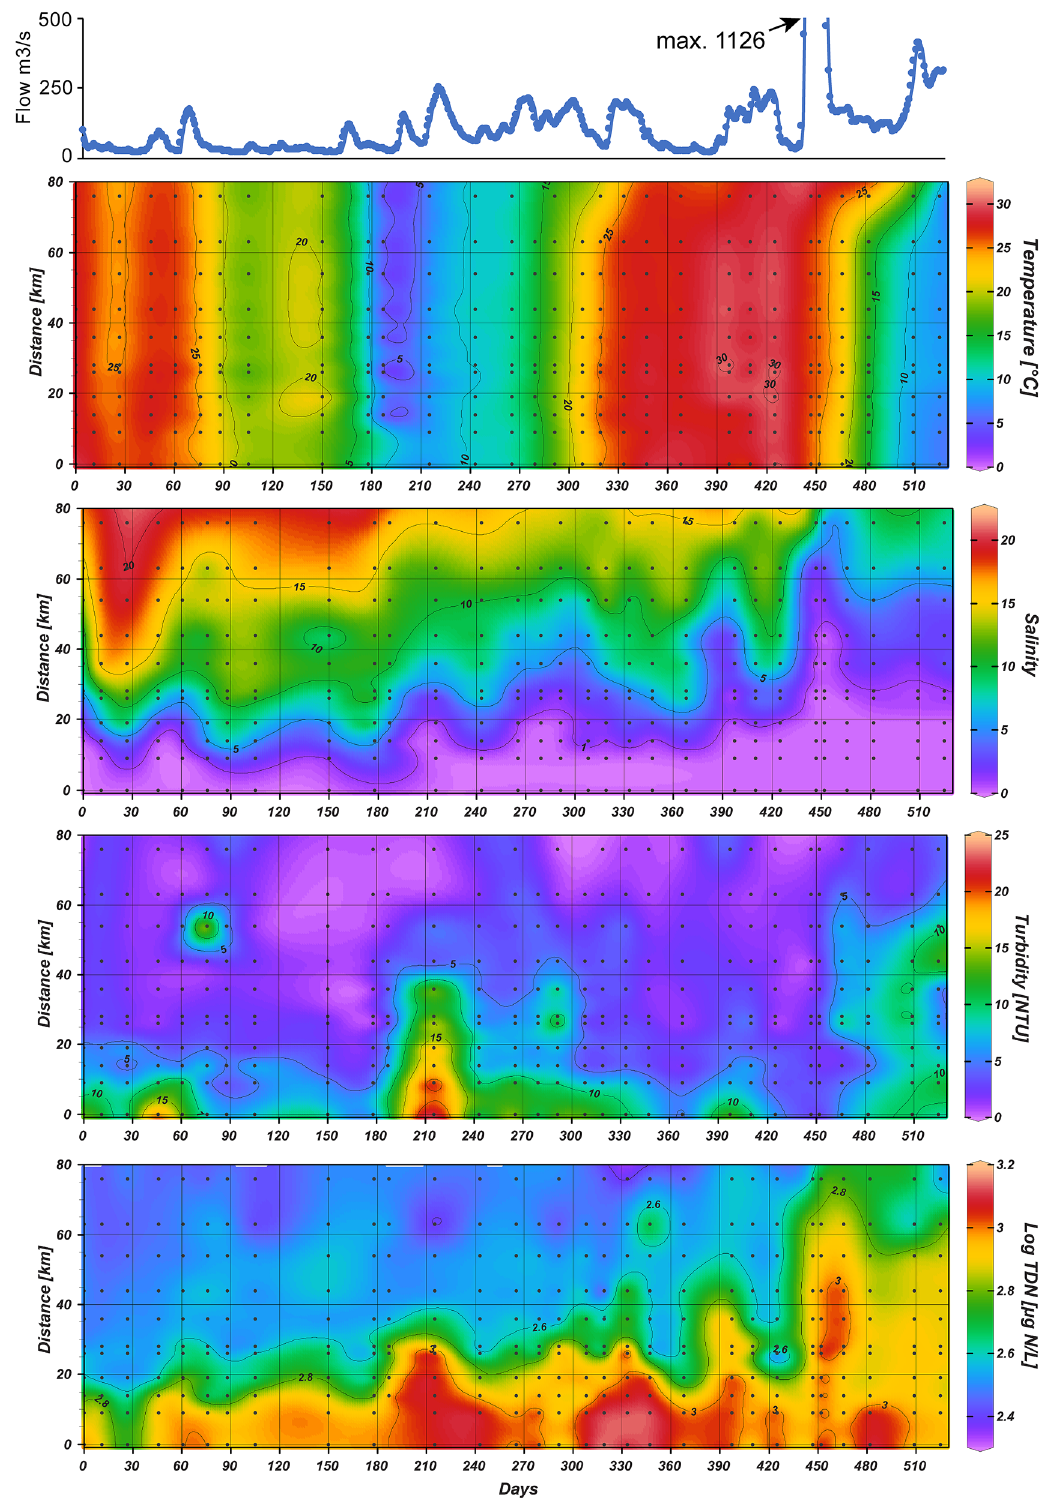
Figure 2. Neuse River flow rate and hydrologic conditions at NRE stations during the study period, July 2017 (study day 0) to December 2018 (study day 525). Flow data (top panel) is from the Ft. Barnwell USGS gauge, including peak flow beyond the plotted range (e.g. 1125 m 3 s −1 ) that occurred after landfall of Hurricane Florence. Note that TDN data is log